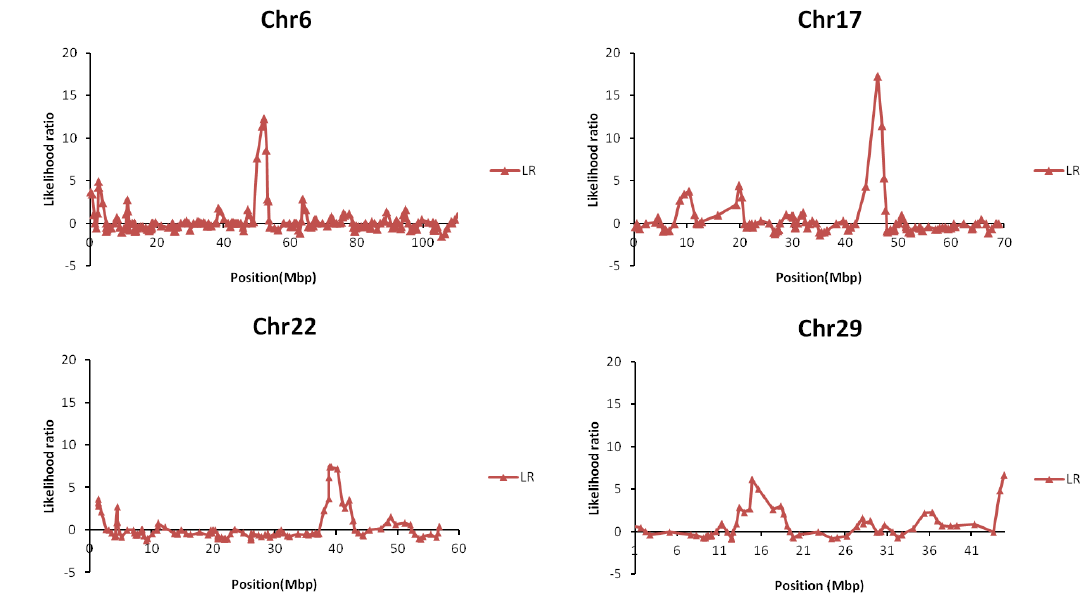
Figure 1. The putative QTL region for